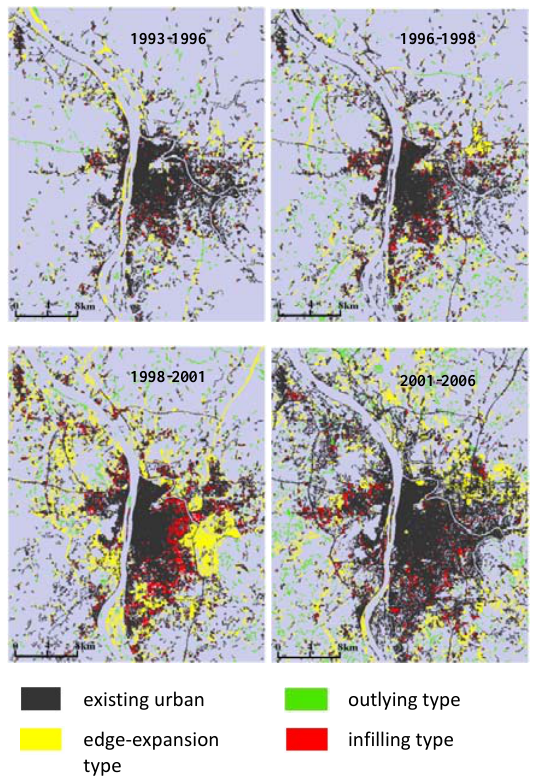
Figure 1. Distribution of urban expansion types in different pe- riods from 1993 to 2006